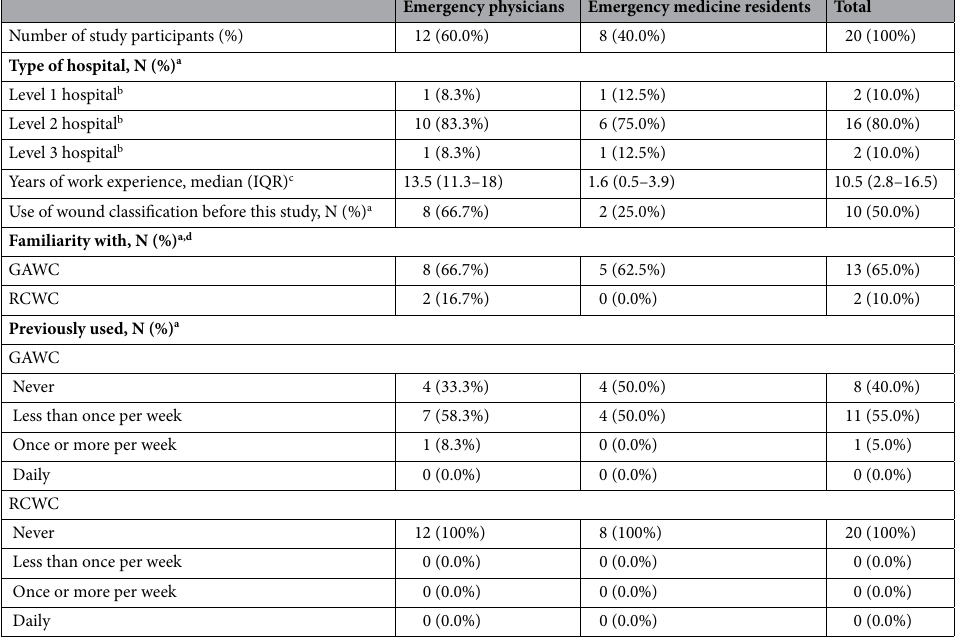
Table 1. Study population basic characteristics and experience with GAWC and RCWC. a Percentages are calculated based on the total number of participants of the column. b Based on the trauma level criteria according to the American college of surgeons. c Total years of experience as an emergency physician or emergency medicine resident. d Familiarity with the classification before participation in this